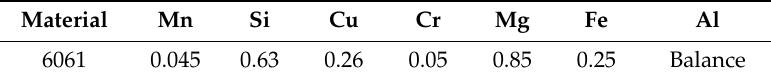
Table 1. Chemical composition of the extruded AA6061 alloy (wt.